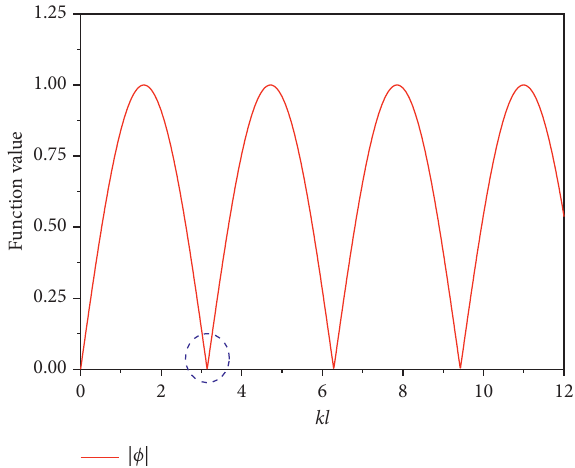
Figure 7: Absolute values of the function φ .